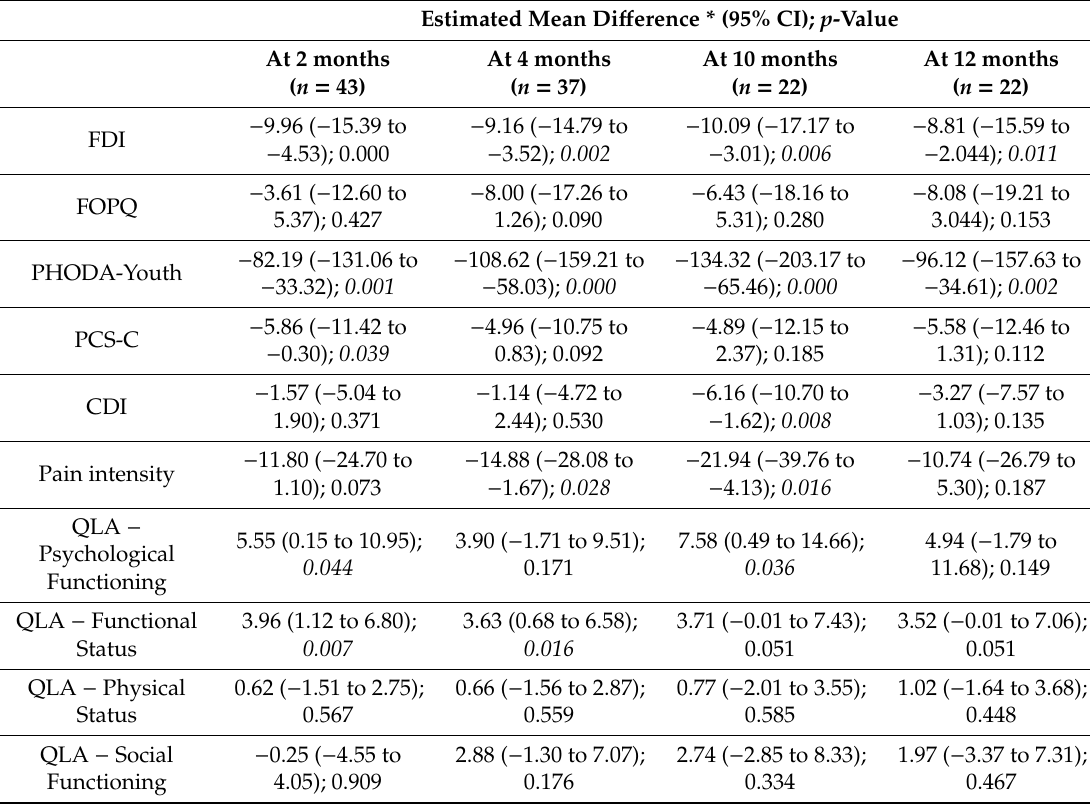
Table 3. Results of Linear Mixed Model analyses for all outcome measures ( n = 53 at baseline).